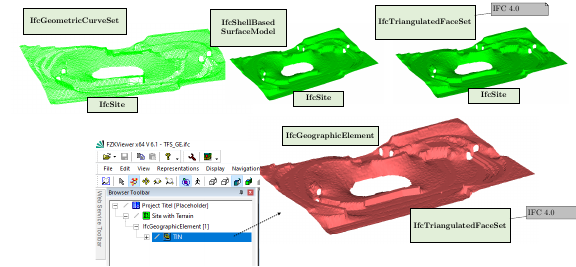
Figure 7. The validity is checked for all export options with the FZK-Viewer